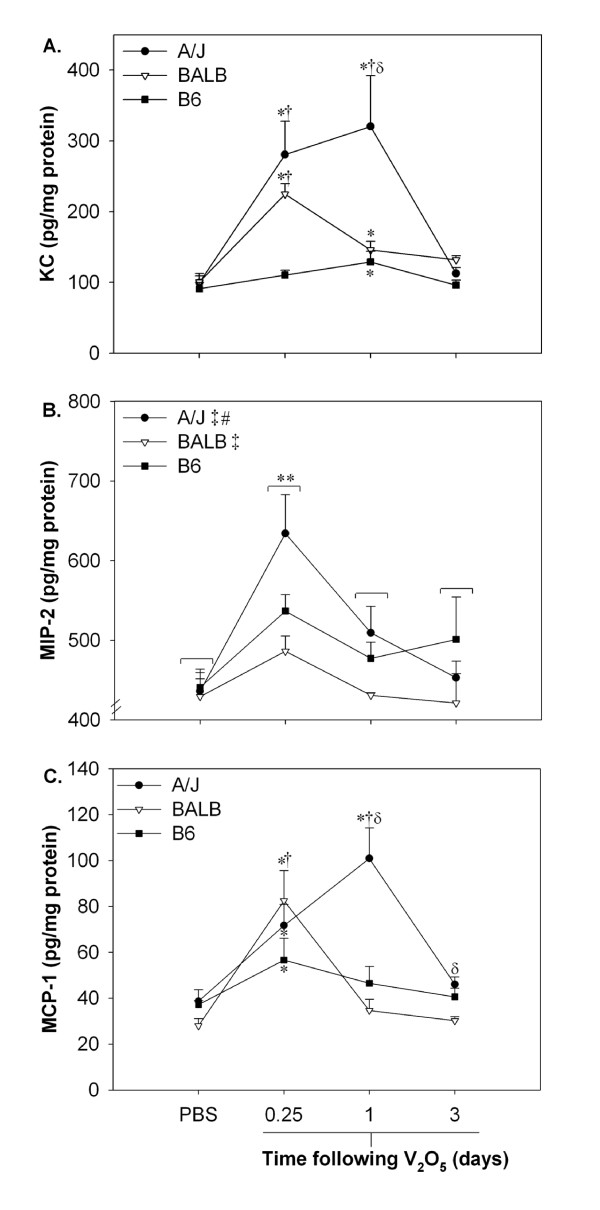
The chemokines KC and MCP-1 are elevated in A/J and BALB mice following V2O5 treatment. A.) KC, keratinocyte chemoattractant, B.) MIP-2, macrophage inflammatory protein-2, C.) MCP-1, monocyte chemoattractant protein-1 levels were determined in lung homogenates (25-50 μg protein) by ELISA. Values are presented as means ± SEM from two independent assays. *, significantly different than strain-matched PBS controls. †, significantly different than time-matched B6 mice. δ, significantly different than time-matched BALB mice. **, significant treatment effect (6 hr V2O5 vs PBS control). ‡, significant strain effect (A/J vs B6, BALB vs B6). #, significant strain effect (A/J vs BALB) (P < 0.05).